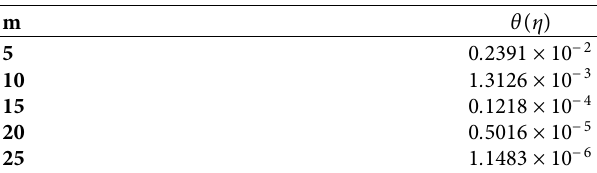
Table 4: The convergence of the flow problem for temperature equation.